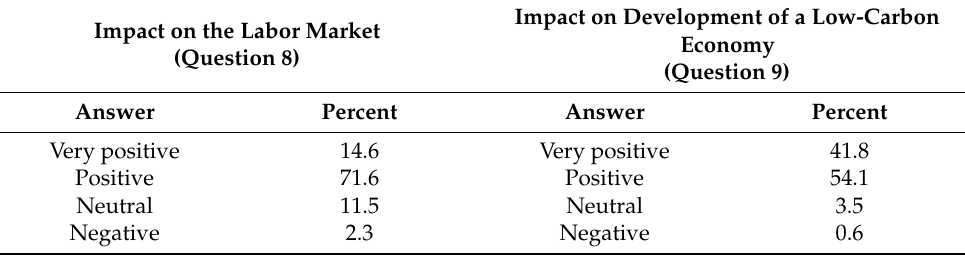
Table 8. Impact of RE development on the labor market and on a low-carbon economy in